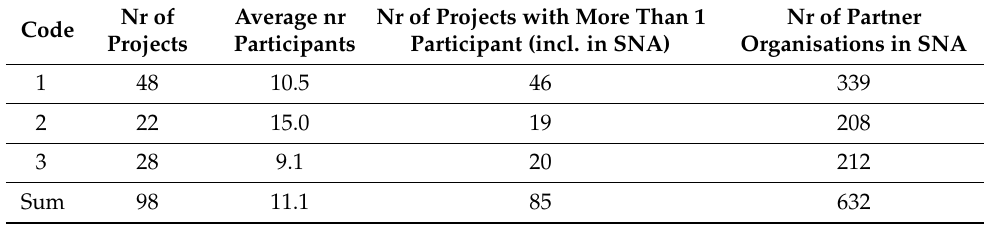
Table 5. Distribution of projects under